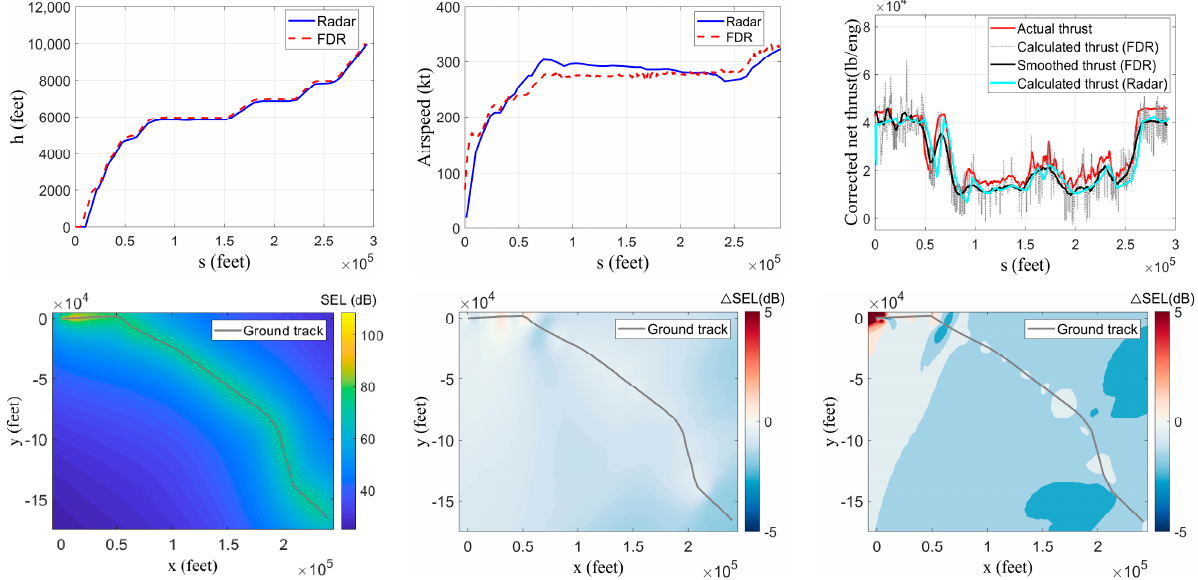
Figure 28. A330 aircraft departing from HKIA (flight AD7). Top: Comparison between the flight profile (left), airspeed (center), calculated and actual thrust (right) inferred from the FDR and radar data. Bottom: Noise contour map, as obtained using FDR data and actual thrust (left). Error entailed by an approximation of the thrust (center: smooth calculated thrust) plus the trajectory estimation (right: radar data, calculated thrust).